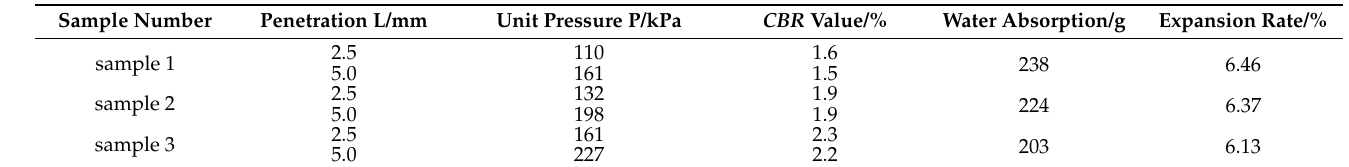
Table 5. Calculation results of CBR value.